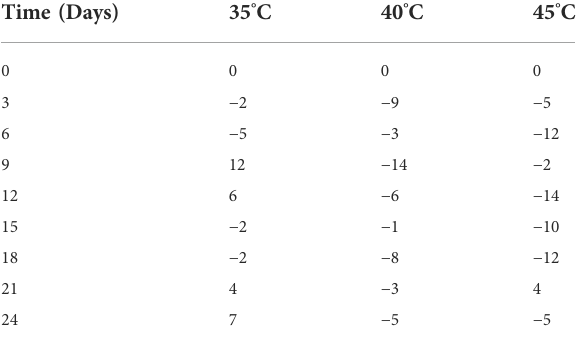
TABLE 1 Strain drift under power cut conditions ( μ ε